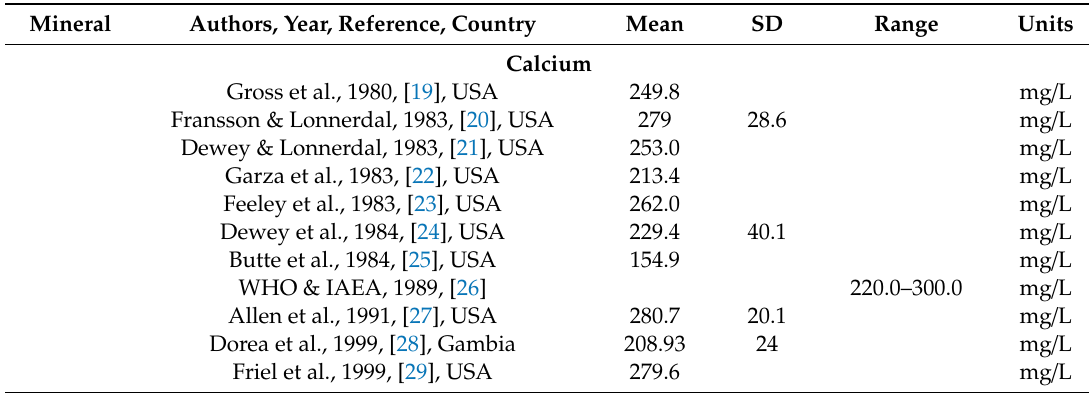
Table 3. Mineral regulated by homeostatic mechanisms [18] reported in mature human milk in di ff erent